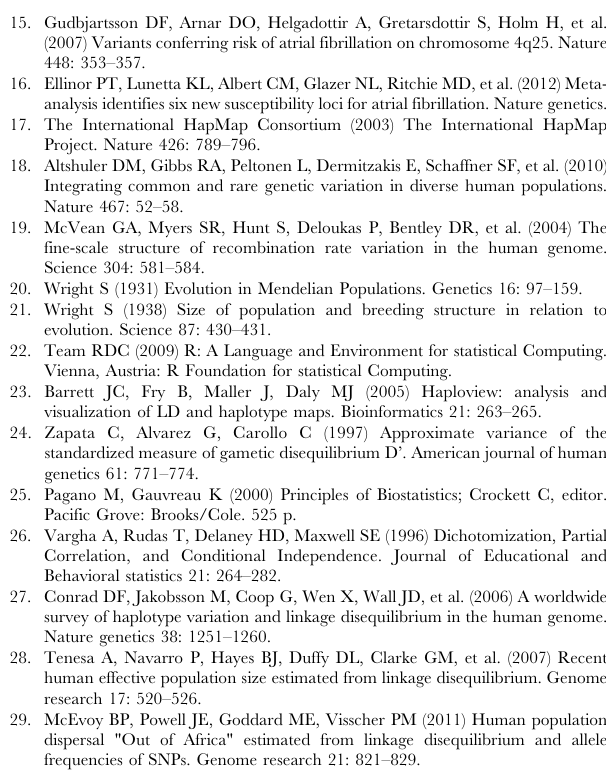
RRW = 1 (gray) vs RRW = 10 (dotted); C) r 2 , RRW = 1 (gray) vs RRW = 0.1 (dotted); D) r 2 , RRW =1 (gray) vs RRW = 10 (dotted). (TIFF) Figure S5 Recombination Rate Weight variation: Re- sampling. Histograms of the change in simulated LD from original LD for each pair of SNPs in Gene Region 1 using Resampling (LD simulated – LD HapMap ). A) D’, RRW = 1 (gray) vs RRW = 0.1 (dotted); B) D’, RRW= 1 (gray) vs RRW= 10 (dotted); C) r 2 , RRW = 1 (gray) vs RRW =0.1 (dotted); D) r 2 , RRW = 1 (gray) vs RRW = 10 (dotted). (TIFF) Figure S6 Heat maps of change in median LD for Gene Region 1 by LD Group. Heat maps of change in median simulated LD from original LD in Gene Region 1 by LD group (median[LD simulated ] – LD HapMap ). Upper left D’, lower right r 2 . Blue indicates a gain in LD; red indicates a loss in LD. (TIFF) Figure S7 Heat maps of change in median LD for Gene Region 1 by MAF Group. Heat maps of change in median simulated LD from original LD in Gene Region 1 by MAF group (median[LD simulated ] – LD HapMap ). Markers are only included in each plot if both markers fall in the MAF group. Upper left D’, lower right r 2 . Blue indicates a gain in LD; red indicates a loss in LD. (TIFF) Figure S8 Heat maps of change in median LD for Gene Region 2 by LD Group. Heat maps of change in median simulated LD from original LD in Gene Region 2 by LD group (median[LD simulated ] – LD HapMap ). Upper left D’, lower right r 2 . Blue indicates a gain in LD; red indicates a loss in LD. (TIFF)